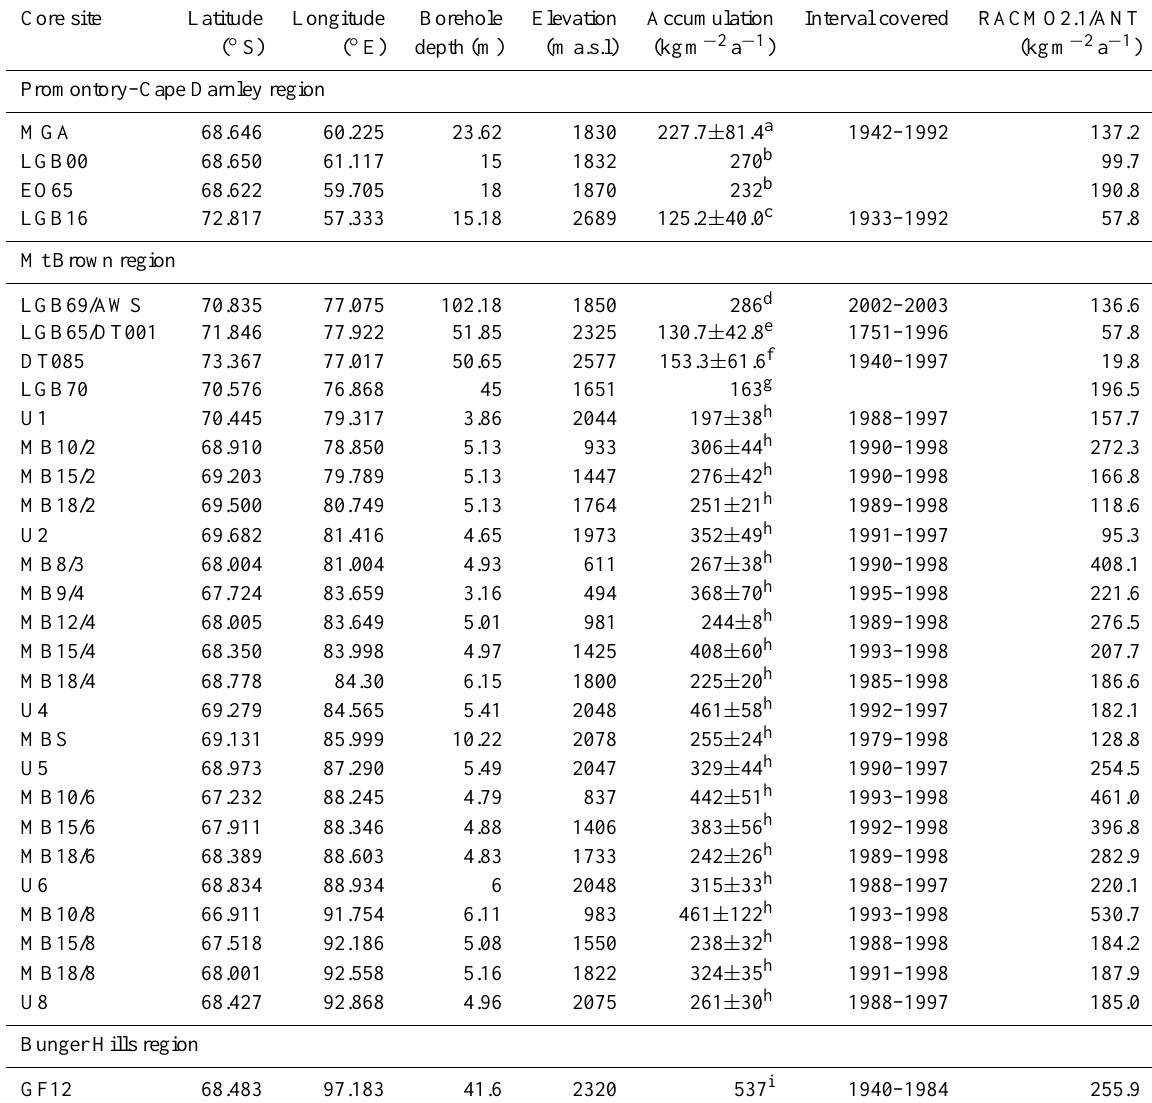
Table 1. Details of existing firn and short ice core records in coastal East Antarctica that are proximal to the areas of interest identified in this